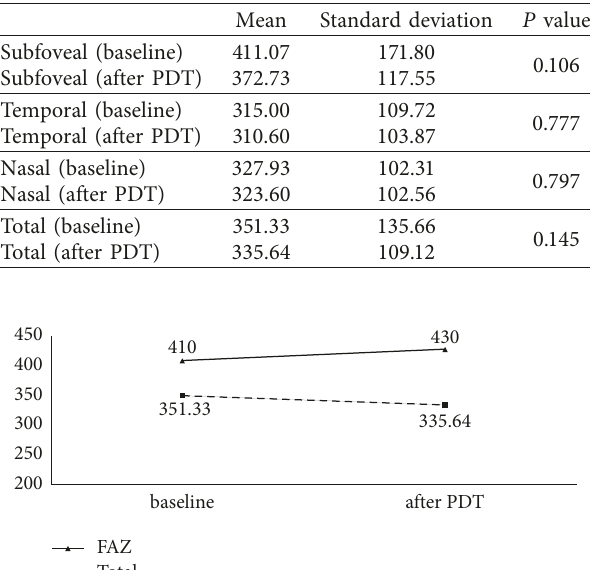
Table 2: Subfoveal choroidal thickness (SFCT) and choroidal thickness 1500 micrometers temporal and nasal to the fovea.